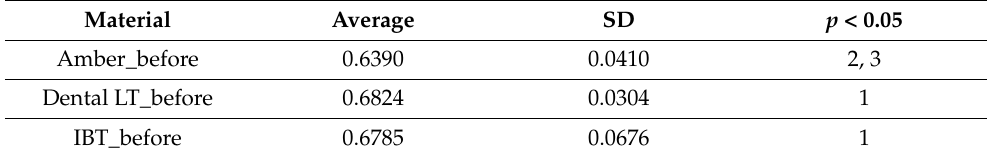
Table 14. Post hoc ANOVA results (least significant difference) for comparing BI values of each